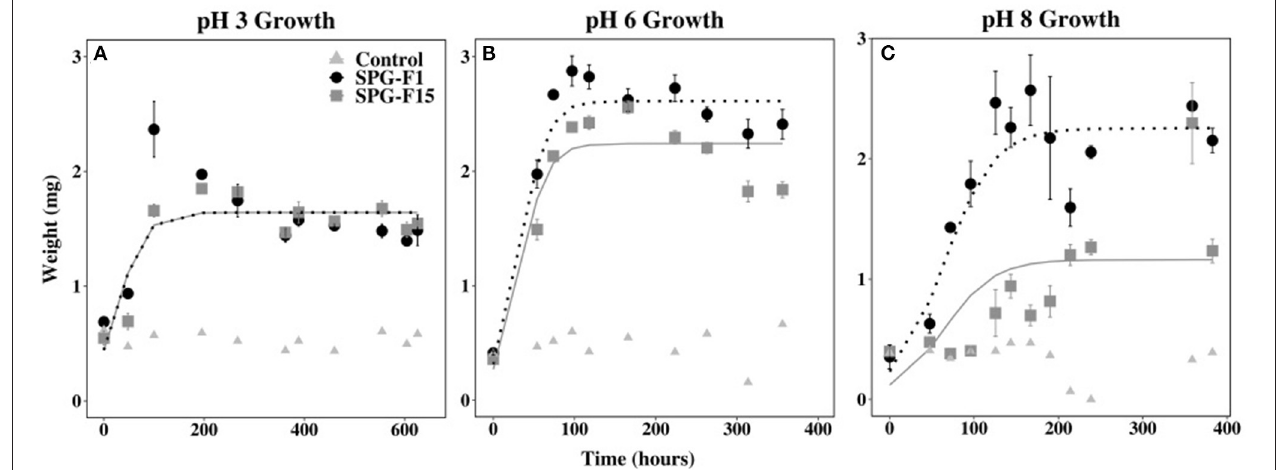
FIGURE 7 | Effect of pH on SPG-F1 and SPG-F15 growth, measured in mg over time. (A) pH 3 growth. (B) pH 6 growth. (C) pH 8 growth. Error bars represent standard error calculated for 3 biological replicates.